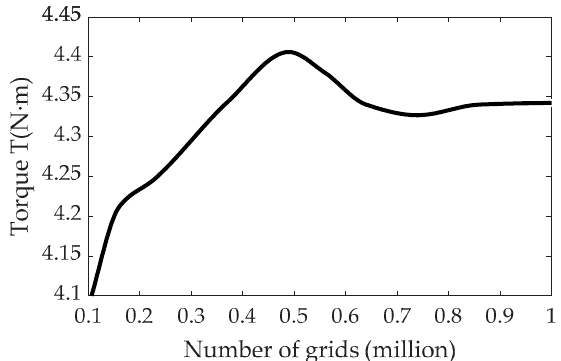
Figure 5. Network independence verification curve.